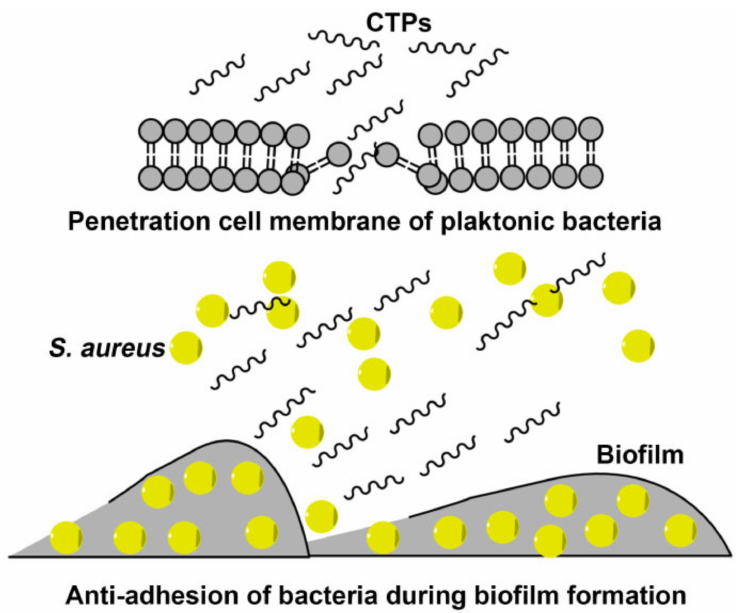
Figure 14. The hypothesized model of antibacterial and antibiofilm effects of CTPs against S. aureus ATCC